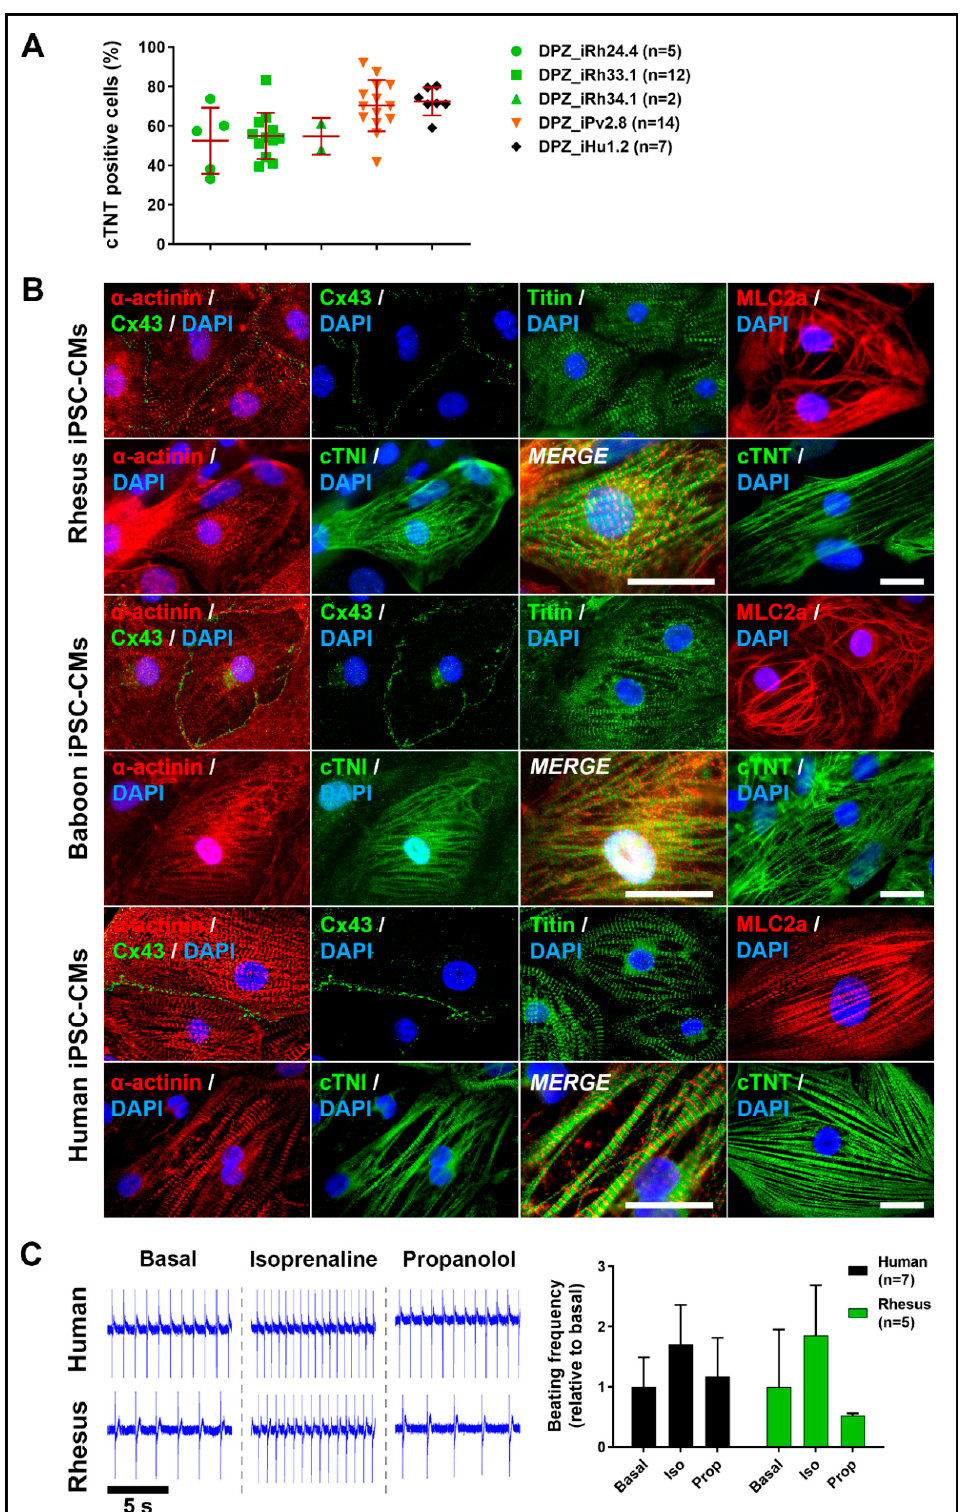
Figure 7. Directed cardiac differentiation of human and NHP-iPSCs. ( A ) Differentiation efficiencies of rhesus, baboon, and human iPSCs reflected by flow cytometric cTNT measurements at day 12 before metabolic selection. ( B ) Immunofluorescence staining of cardiac-specific proteins show structure and morphology of rhesus and baboon iPSC-derived cardiomyocytes: sarcomeric α -actinin,